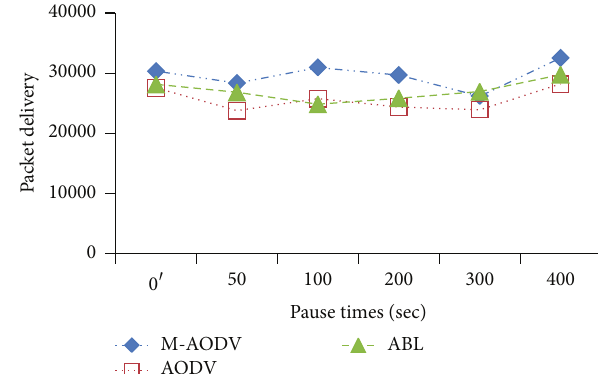
Figure 2: Packet delivery ratio in first scenario.